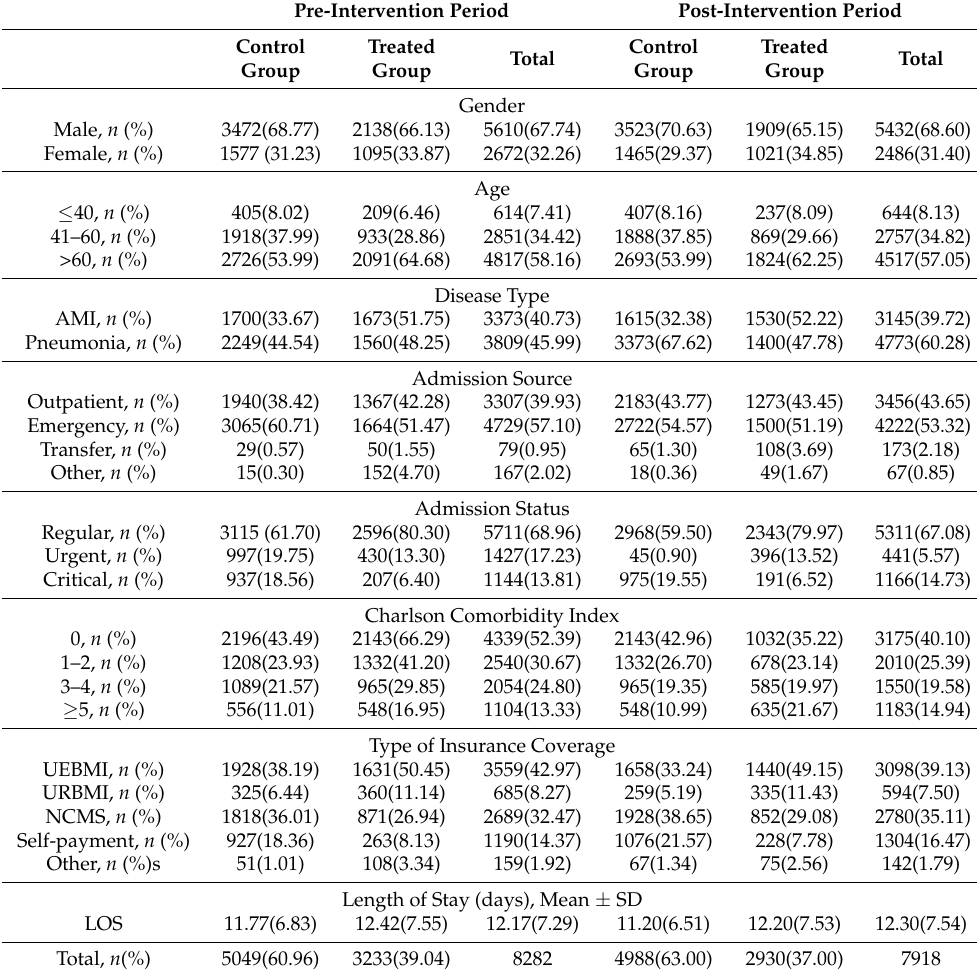
Table 1. Descriptive statistics of the patient characteristics during pre- and post-treated